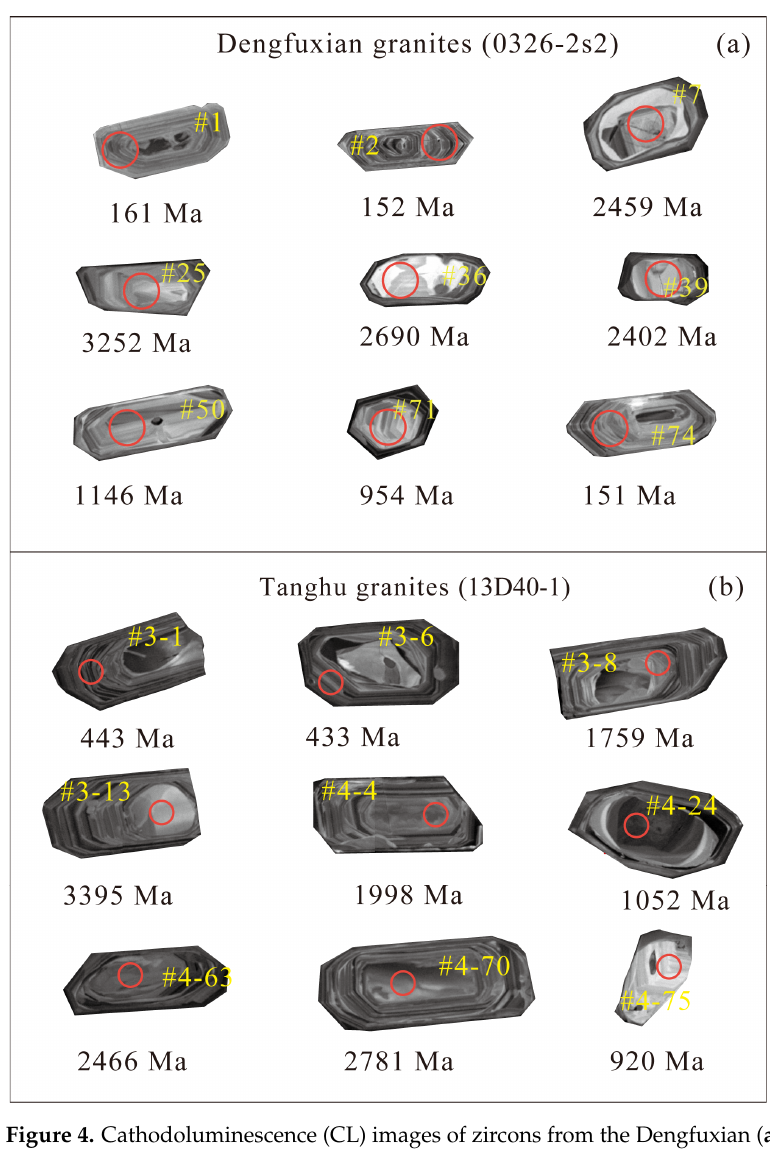
Figure 4. Cathodoluminescence (CL) images of zircons from the Dengfuxian ( a ) and Tanghu granites ( b ). The red circle is the location for the LA ‐ ICP ‐ MS dating. The red circle diameter, marked on zircons, is ca. 29 μ m. The numbers under the zircon grains represent the U ‐ Pb ages of the corresponding zircon. The selected ages in this study followed the procedure that the young ages (lower than 1000 Ma) and old ages (higher than 1000 Ma) used 206 Pb/ 238 U ages and 207 Pb/ 206 Pb ages, respectively.